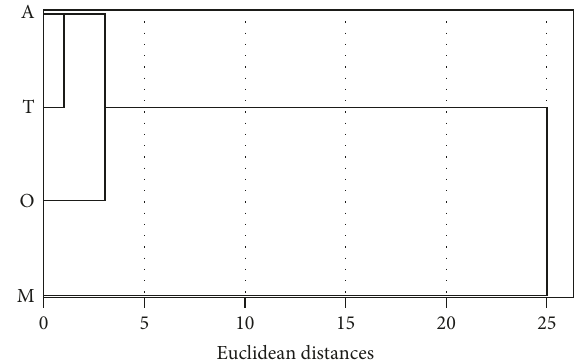
Figure 3: Relationships between populations of Cedrus atlantica ( A , A¨ıt Ayach; T , Tazekka; O , A¨ıt Oufella; M , Moudemame) on the shortest Euclidean distances in relation to the morphological and anatomical characteristics of